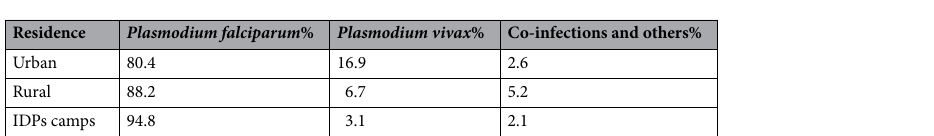
Table 1. The percentage of malaria parasite prevalence in Sudan according to residential status. These data were published in the Sudan MIS 2016 report.